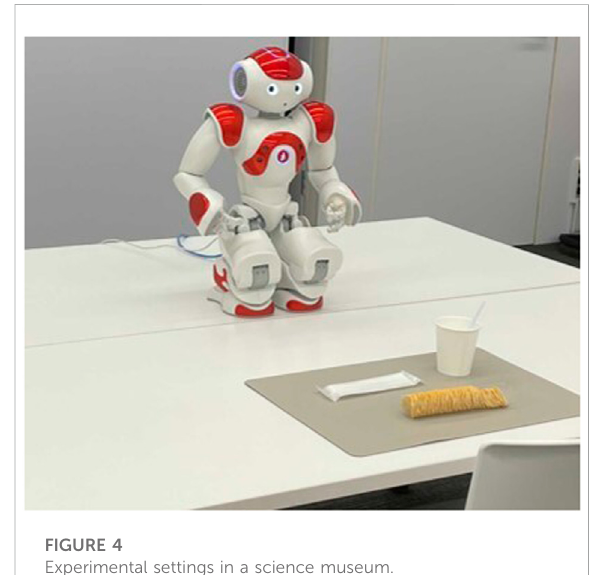
FIGURE 4 Experimental settings in a science